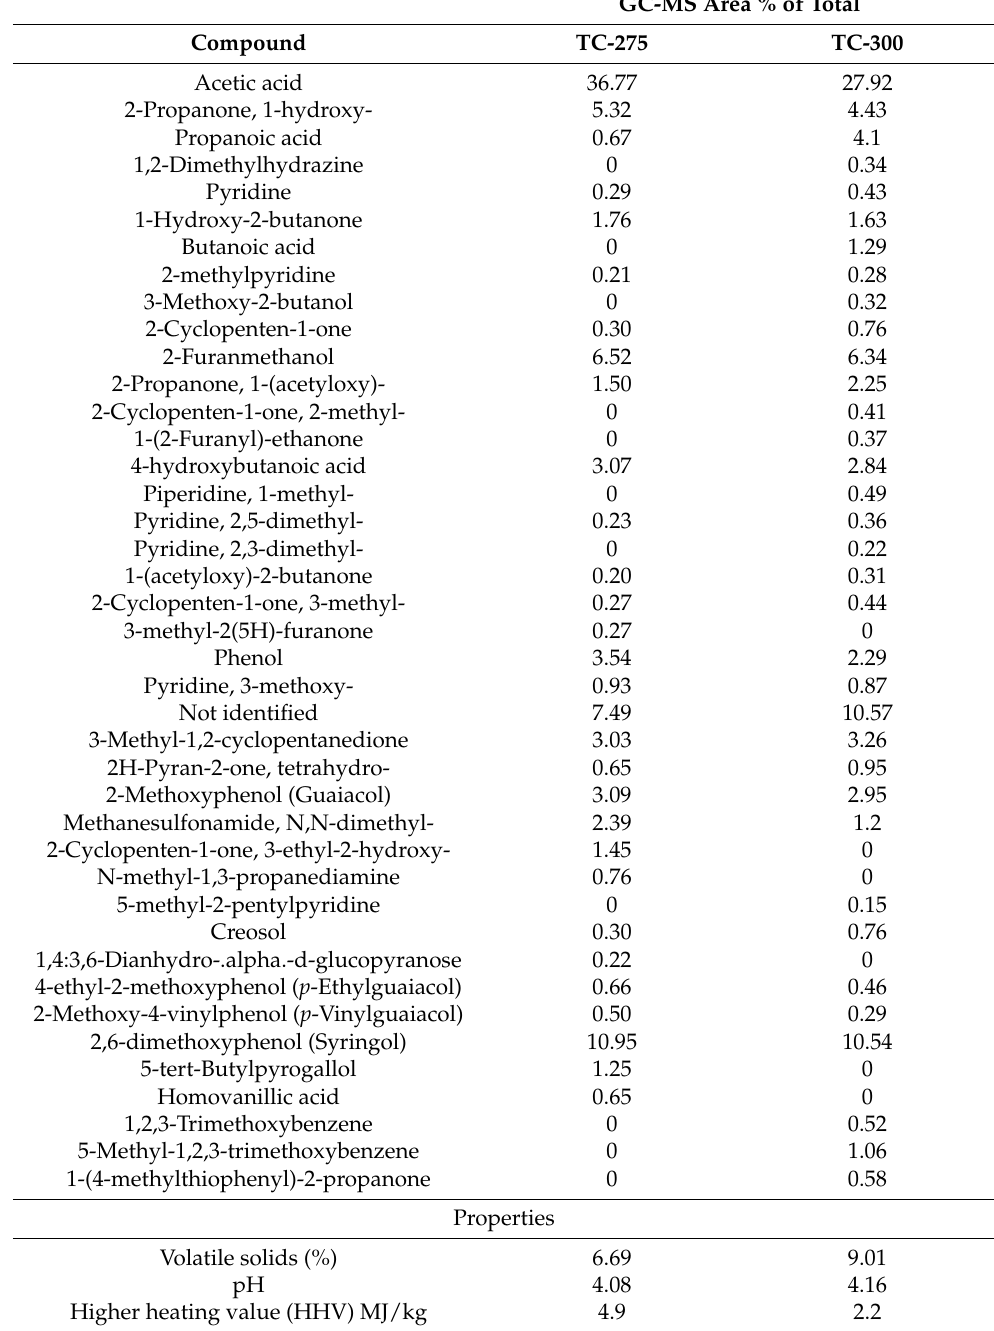
Table 1. Chemical composition and physiochemical properties of pulp sludge derived torrefaction